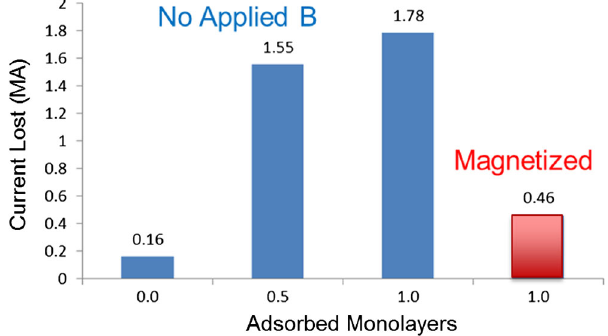
FIG. 11. The peak current loss (after 100 ns) in the 17b geometry is shown for unmagnetized and magnetized MITL and adsorbed surface water. Note that N water